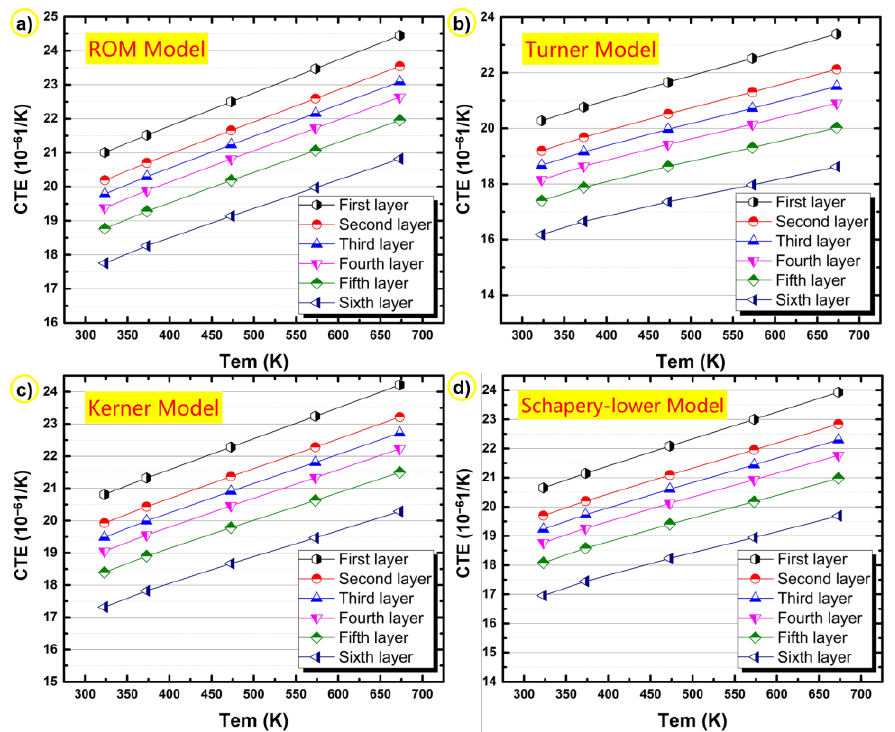
Figure 8. Calculated CTEs of the bimetallic gradient alloy in different layers using the ( a ) ROM model, ( b ) Turner model, ( c ) Kerner model, and ( d ) Schapery lower